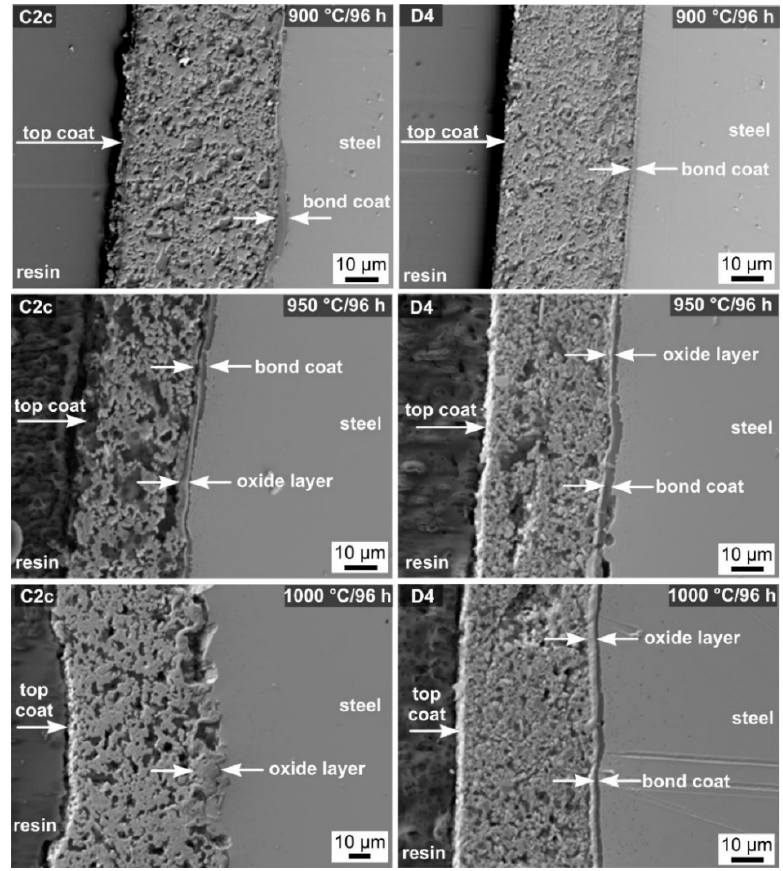
Figure 8. SEM cross ‐ sections of layers C2c and D4 after oxidation tests in water. Figure 8. SEM cross-sections of layers C2c and D4 after oxidation tests in water.